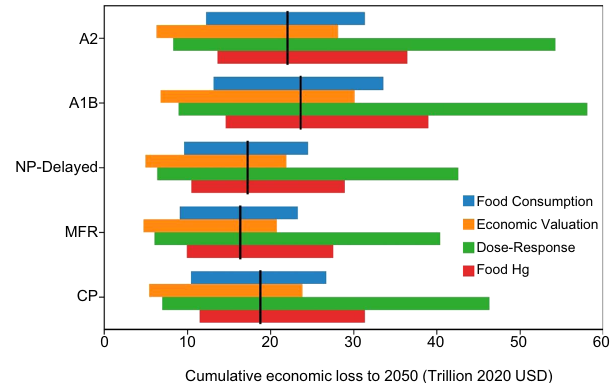
Fig. 5 Range in cumulative health impacts (unit: US dollars in 2020 value) to 2050 for the CP (current policy), MFR (maximum feasible reduction), NP-Delayed (new policy delayed), A1B (business as usual), and A2 (divided world scenario) scenarios. Bars indicate the sensitivity of cumulative health effects to high and low case assumptions for uncertain parameters (as 95% con fi dence intervals): food consumption, economic valuation, dose-response parameterization, and food methylmercury concentrations. The black lines are our best